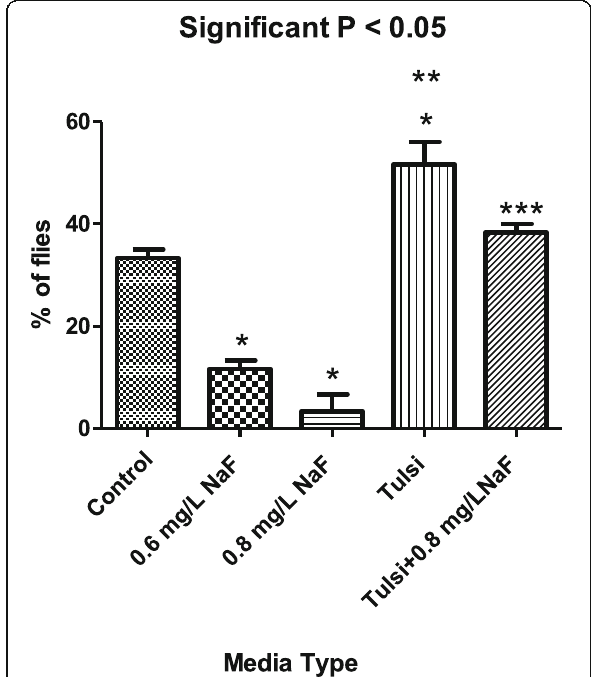
Fig. 5 Climbing ability of Drosophila melanogaster after 12 days of eclosion. *, significant difference between control vs NaF and tulsi; **, significant difference between tulsi vs NaF; ***, significant difference between tulsi+0.8 mg/L NaF vs